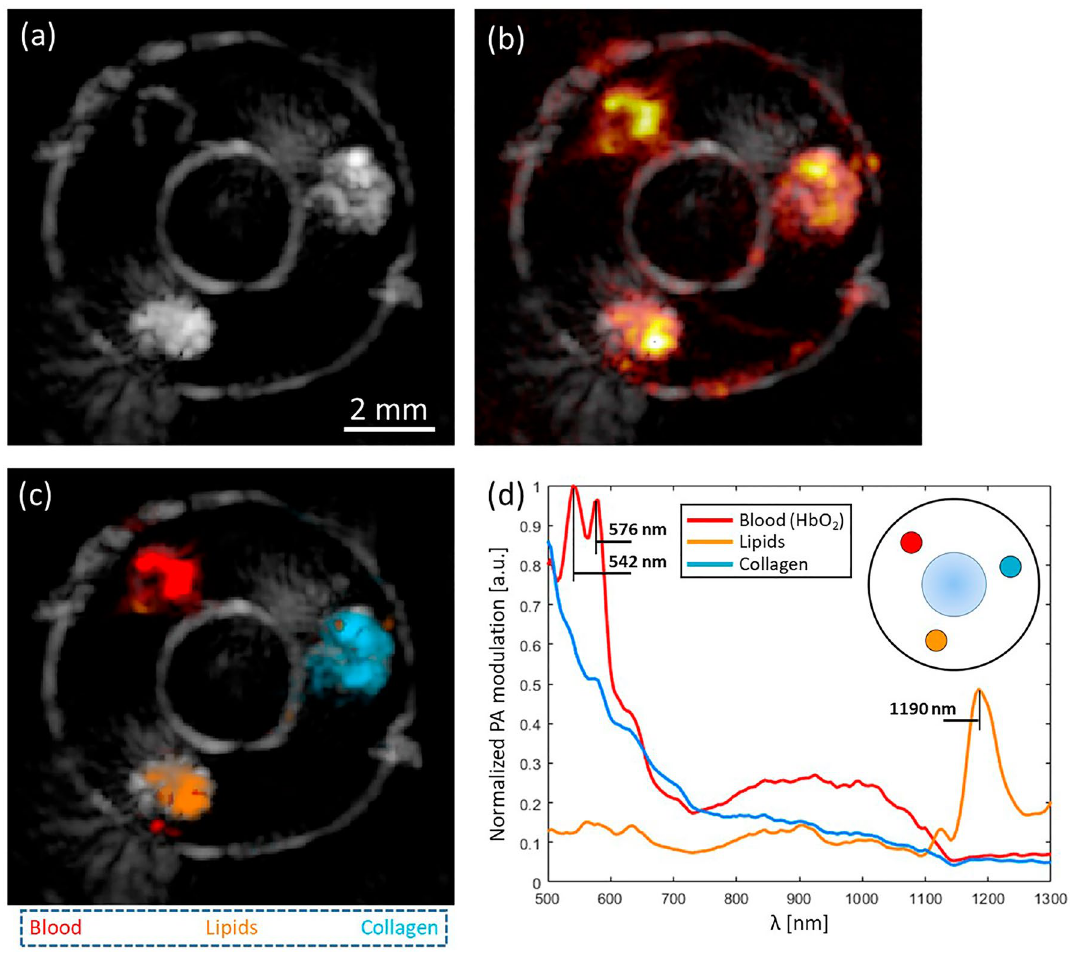
of oxygenated hemoglobin (HbO 2 ), lipids, and collagen using 162 imaging wavelengths. ( d ) Endmembers calculated from the PA signal of each material (with water absorption correction). Abundance map coincides with the phantom geometry and the endmembers confirm the composition of the channels.